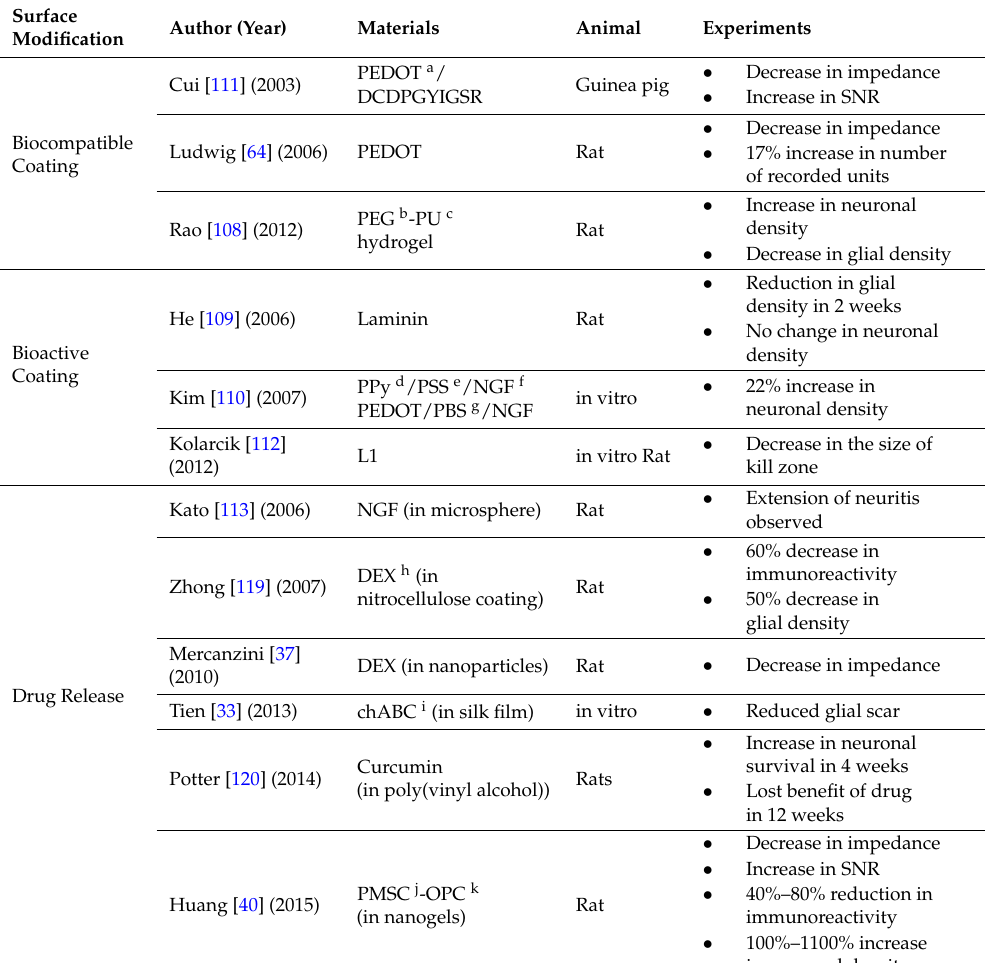
Table 3. Summary of surface modification